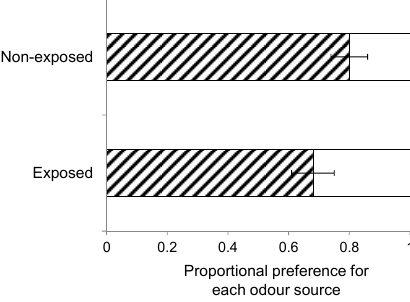
Figure 4. Landing preference of female Cotesia glomerata eclosing from cocoons produced by host caterpillars that had been removed from the plants before the parasitoid larvae egressed from the host (non-exposed group, top bar ) and those eclosing from cocoons that were left on the plants on which the caterpillars had developed until adult eclosion (exposed group, bottom bar ). Wasps had been reared on Sinapis arvensis and were given the choice between a Brassica rapa ( dashed bars ) and a S. arvensis plant ( white bars ) infested with 20 first instar Pieris brassicae for 24 h. Bars present the mean proportion (±SE) of choice based on 10 replicate bioassays each tested with 10 responding wasps. There were significant differences in the amount of leaf tissues consumed by P. brassicae larvae among the three plant species (F 2,54 = 3.38, p = 0.041) (Figure 5). The damage inflicted to S. arvensis plants was marginally, though not statistically, greater than the damage inflicted to B. rapa (Tukey test: p = 0.06, Figure 5) and B. nigra (Tukey test: p = 0.08, Figure 5). Damage levels were similar on B. rapa and B. nigra plants (Tukey test: p = 0.99, Figure 5).